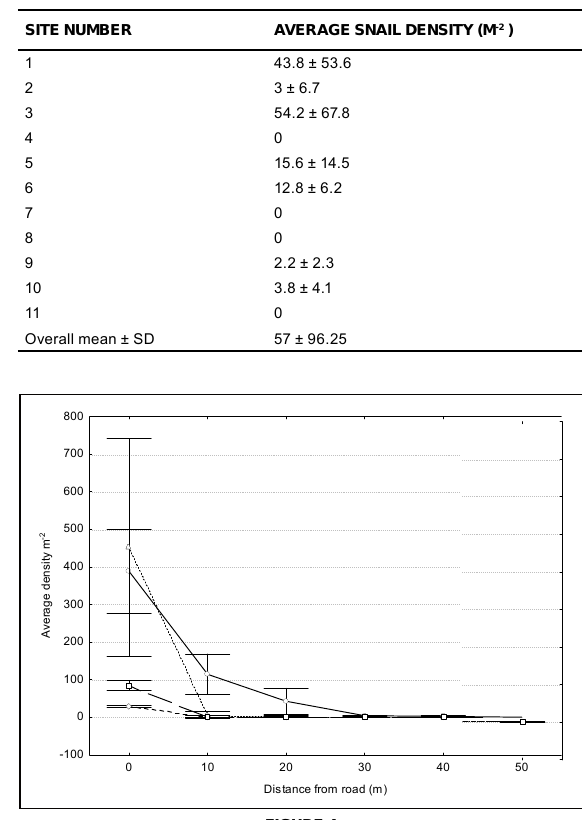
tAble 1 Mean snail density (m -2 ± SD) at 11 sites adjacent to the